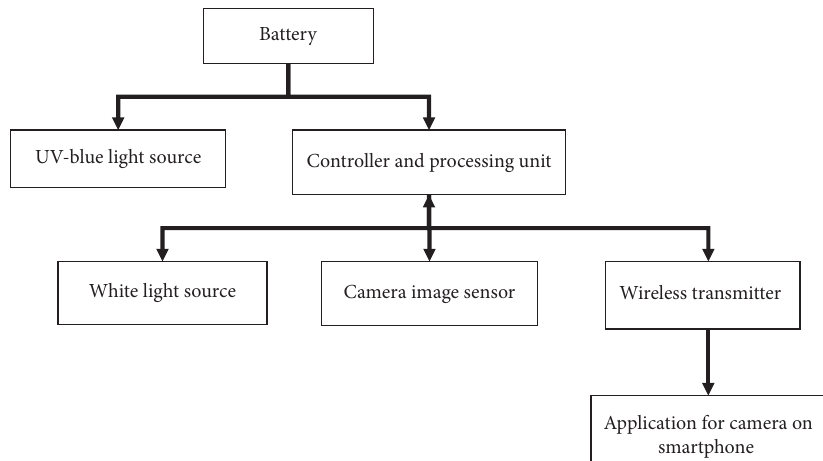
Figure 1: The overall device mechanism.